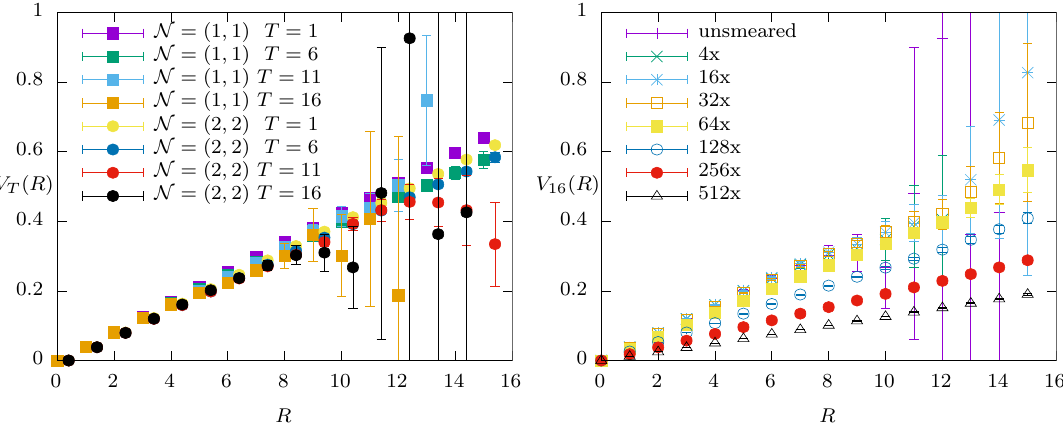
Figure 3. Left: static fundamental quark-antiquark potential of N =(1 ; 1) and N =(2 ; 2) SYM theory. The measurements where done for several temporal extends T on the 64 (cid:2) 32 lattice includ- ing reweighting of the Pfa(cid:14)an. The N =(2 ; 2) data is shifted slightly for clarity of presentation. Right: comparison of di(cid:11)erent levels of STOUT smearing with smearing parameter (cid:15) = 0 : 4 for the N =(2 ; 2) SYM with temporal Wilson loop size T = 16.